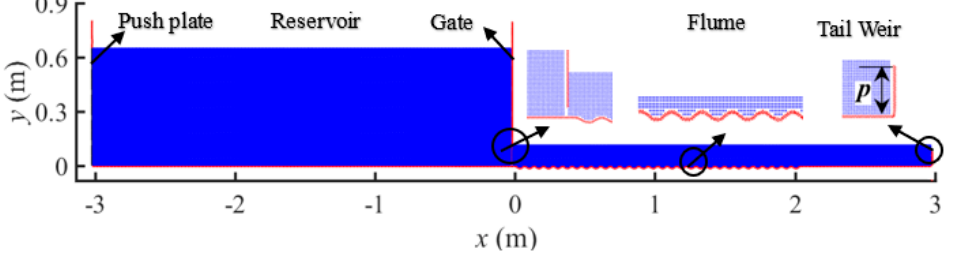
Figure 2. SPH computational domain of the benchmark example.